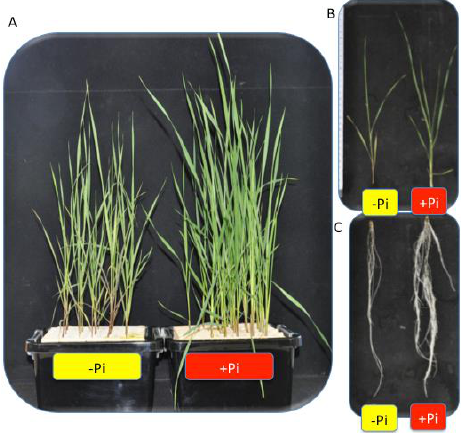
Figure 1. Changes in wheat growth under different phosphate conditions. ( A ) Wheat were grown hydroponically for three weeks in presence (+P) or absence (−P) of inorganic phosphate (KH 2 PO 4 ). ( B ) shoot and ( C ) root of wheat grown either in presence (0.5 mM) or in absence of inorganic phosphate for three weeks.